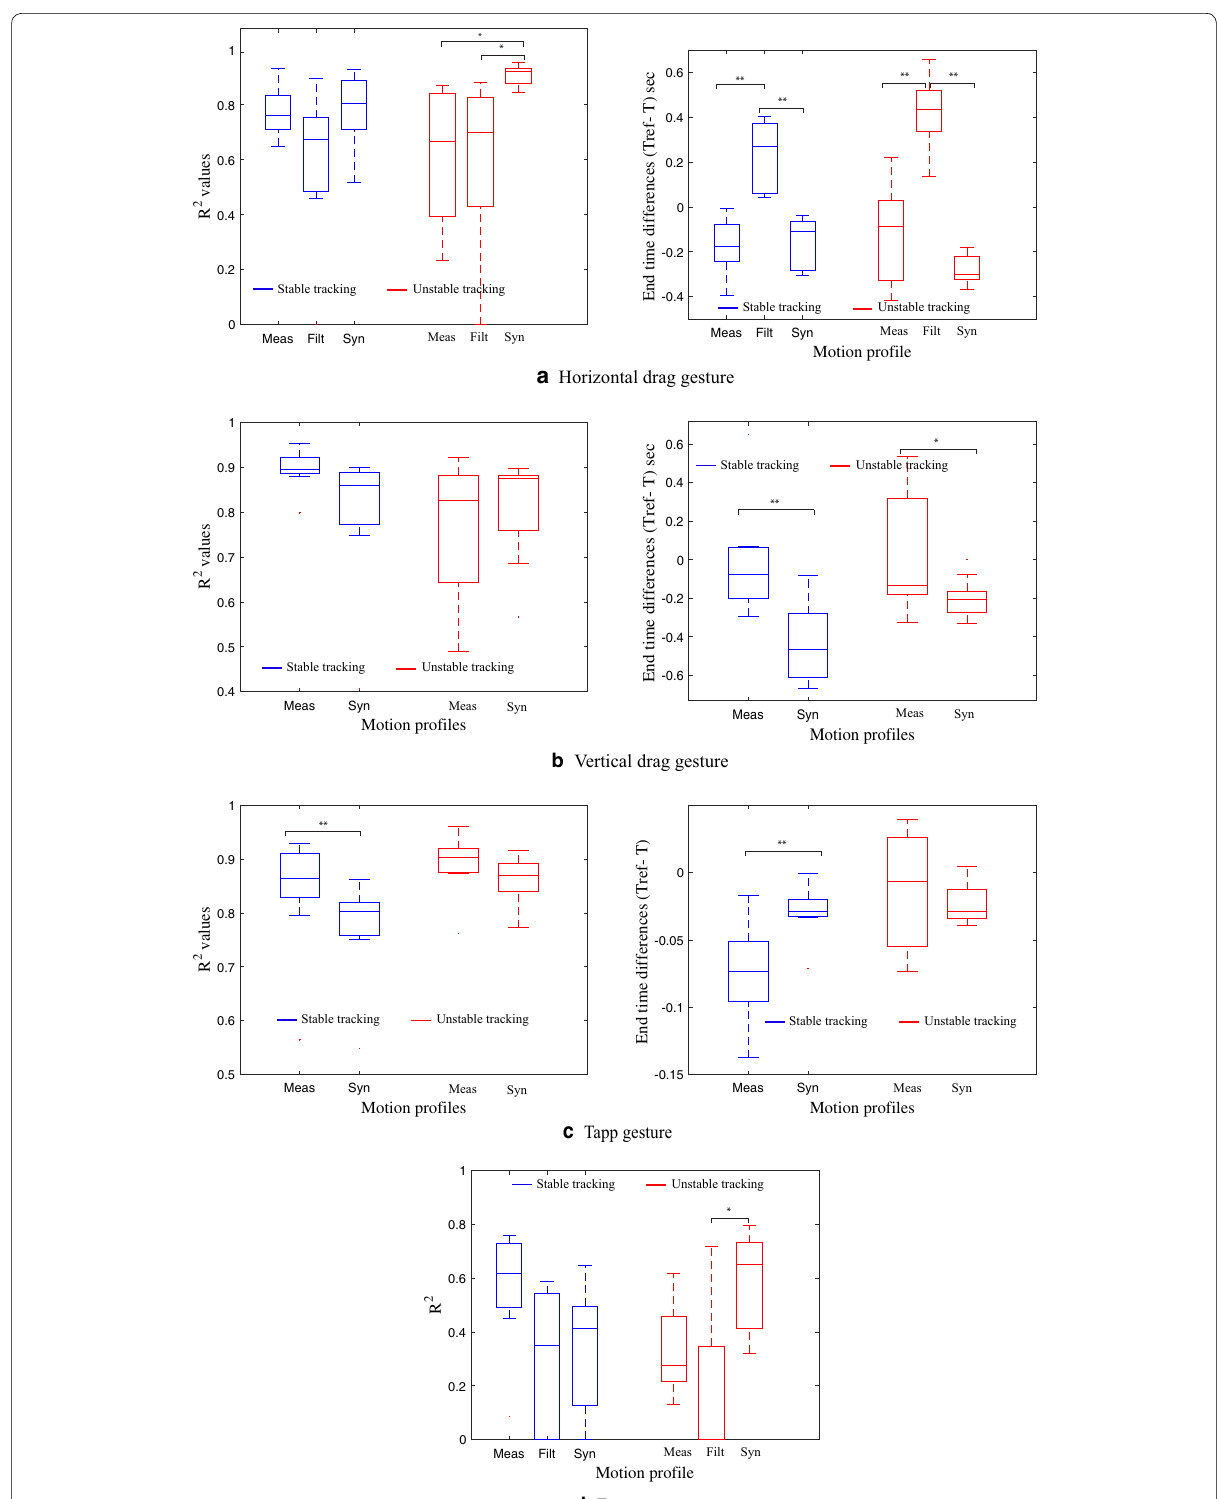
Fig. 7 Quantitative evaluation results. Quantitative evaluation results showing the shape and end timings of the motion profiles during gestures. a Horizontal drag, b vertical drag, c tapping, d zooming. Here the Meas corresponds to measured motion data, Syn synthesized motion and filt filtered motion data respectively (** p < 0.001 and * p < 0.05. Adjustment for multiple comparisons: